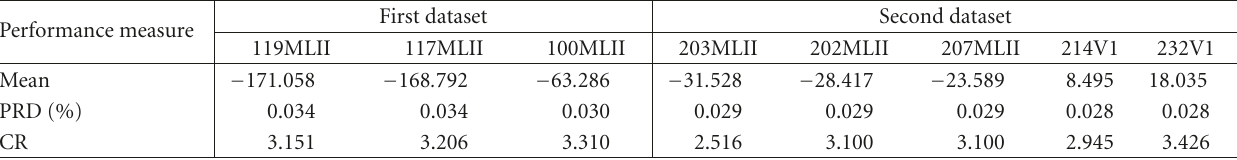
Table 5: Relationship between the mean values of the signal and performance of the proposed compression schemes.